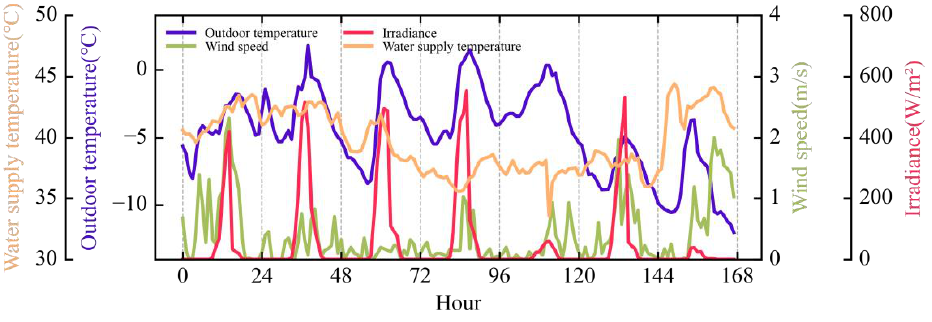
Figure 12. Disturbance factors for one